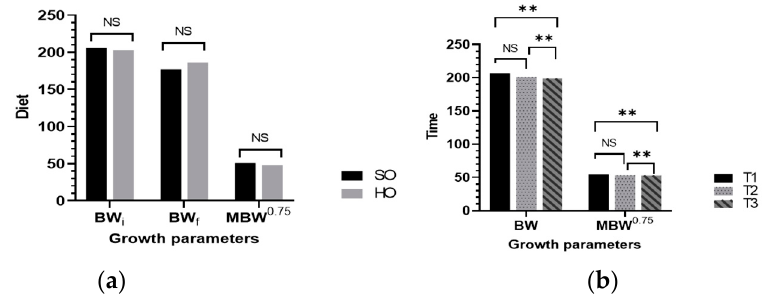
Figure 1. Mean of growth parameters of primiparous sows: ( a ) effect of diet (classical diet based on soybean oil, SO, or a rich n-3 FA and lower n-6:n-3 ratio diet based on hemp seed oil, HO) on BW and MBW; ( b ) effect of time (12 h, 10 days, and 21 days) on BW and MBW. Abbreviations: body weight, BW; metabolic body weight, MBW 0.75 ; Time: T1 = 12 h after farrowing, T2 = 10 days, T3 = 21 days; NS: nonsignificant effect; ** p < 0.01 highly significant difference between means.